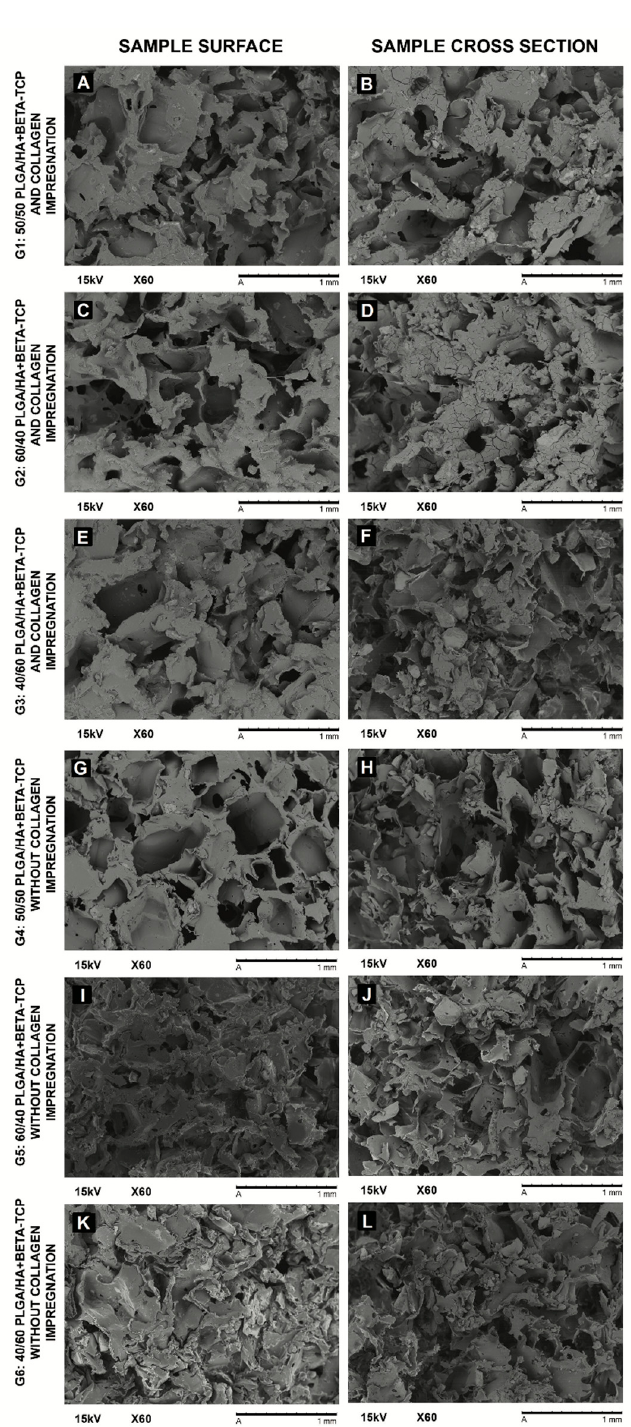
Figure 1. Scanning electron microscopy surface ( A , C , E , G , I , K ) and cross-section ( B , D , F , H , J , L ) images of the composite scaffolds made of polylactic-co-glycolic acid (PLGA) and biphasic ceramic (HA + β -TCP) at different ratios with G1: 50/50 ( A , B ), G2: 60/40 ( C , D ), and G3: 40/60 ( E , F ) and without G4: 50/50 ( G , H ), G5: 60/40 ( I , J ), and G6: 40/60 ( K , L ) collagen impregnation. In all groups, a structure with open pores and visible interconnectivity was produced. In groups G1, G2, and G3, collagen was able to coat both PLGA and HA + β -TCP, although group G3 exhibited several agglomerated ceramic particles. The groups without collagen coating presented a rougher morphology, and the HA + β -TCP particles seemed separated from the matrix; moreover, the agglomerates increased by increasing the amount of ceramic (G5 < G4 < G6). Magnification 60×.